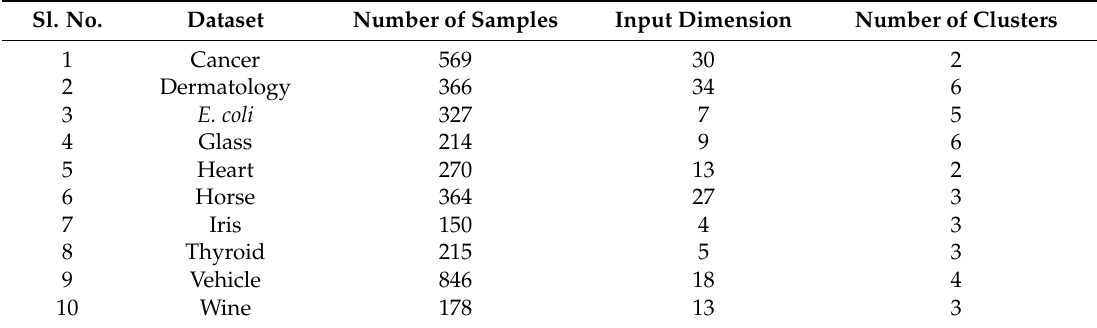
Table 1. Properties of the dataset.